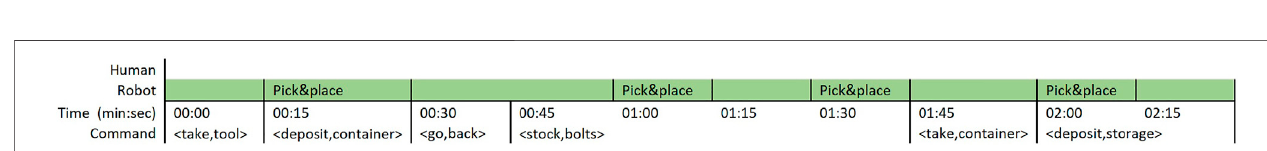
FIGURE 10 | Task assignment chart for kitting by speech coordination. The chart depicts only the actions of the robot (green), as it acts alone. The commands requested by the human to the robot are different from the graphical command-based scenario.